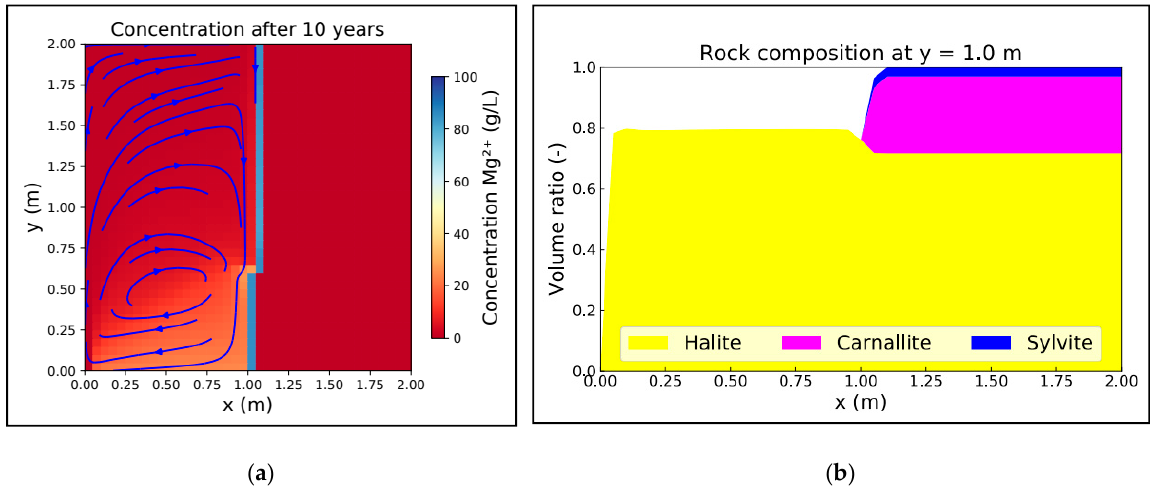
Figure 9. ( a ) Mg 2+ concentration distribution and ( b ) mineralogy for a reaction- and advection-dominated system (scenario: dissolution rate 10 − 6 cm/s and 20 wt.% carnallite).